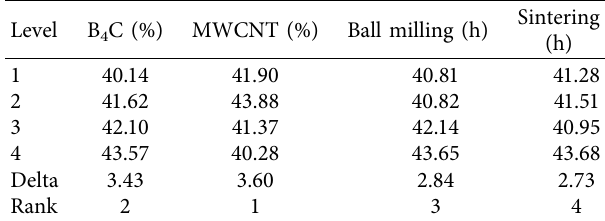
Table 8: Response table for signal-to-noise ratios. Larger is